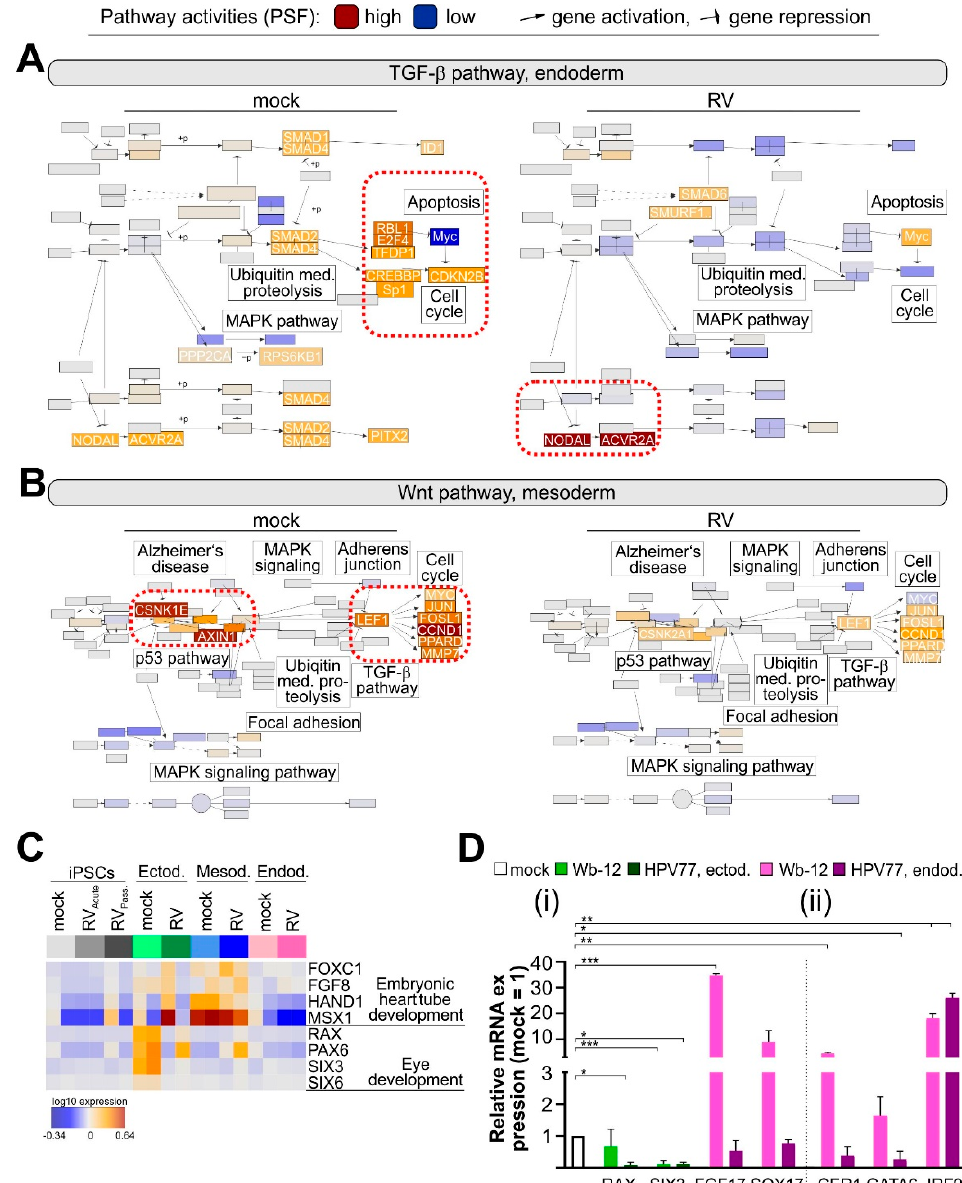
Figure 6. RV exerts lineage-specific effects on developmental signaling pathways and alters expression of transcription and growth factors. Pathway signal flow (PSF) activity plot of ( A ) the TGF- β signaling pathway in endodermal cells (highlighted are genes with higher (NODAL, ACVR2A, Myc) and lower (RBL1 and E2F4) activity after RV infection) and ( B ) of the Wnt signaling pathway in mesodermal cells (highlighted are genes with lower (the CSNK1E/AXIN1E and the LEF1/CCND1 axis) activity after RV infection). The calculation of the activity of the nodes was based on the PSF algorithm using the respective gene expression values and the wirings between the nodes [21]. ( C ) Selected genes within pathways that were specifically affected by RV infection are illustrated in the heatmap of the transcriptome of mock- and RV-infected iPSCs and iPSC-derived lineages. ( D ) For qRT-PCR expression analysis, the 2 −∆∆ Ct method based on normalization to HPRT1 gene was used. Values are given as means ± SD (n = 4 for Wb-12-infected ectoderm, n = 2 for HPV77-infected ectoderm, otherwise n = 3). See also Figures S5–S7.